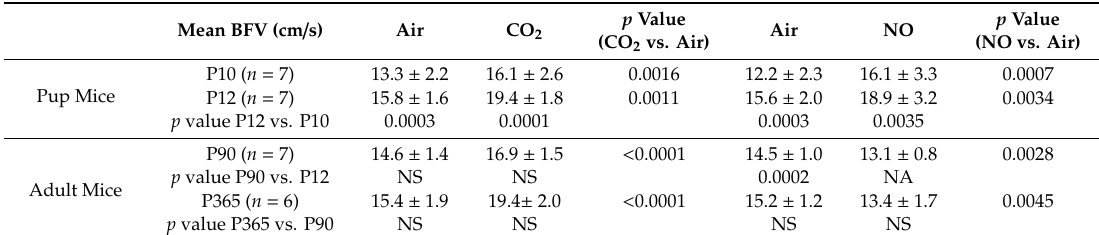
Table 1. Mean blood flow velocities (mBFVs) recorded in the basilar trunk in control (naive) mice